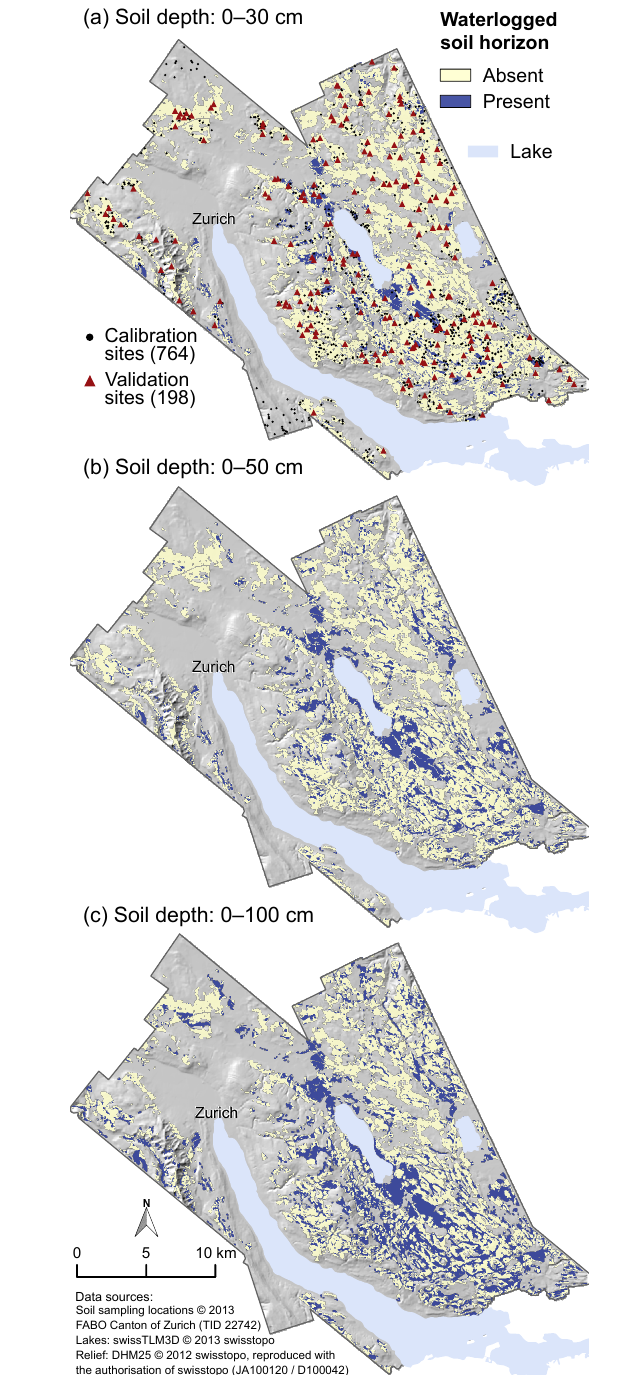
Figure 6. The geoGAM predictions of the presence of waterlogged horizons between the surface and three soil depths ( (a) 0–30, (b) 0– 50, (c) 0–100cm) for the agricultural land in the Greifensee study region (computed on a 20m grid with final geoGAM, with covari- ates according to Table 2, smoothed for better display with focal mean with radius of 3 pixels = 60m). Black dots in panel (a) are locations used for geoGAM calibration, and locations with red tri- angles were used for model validation.